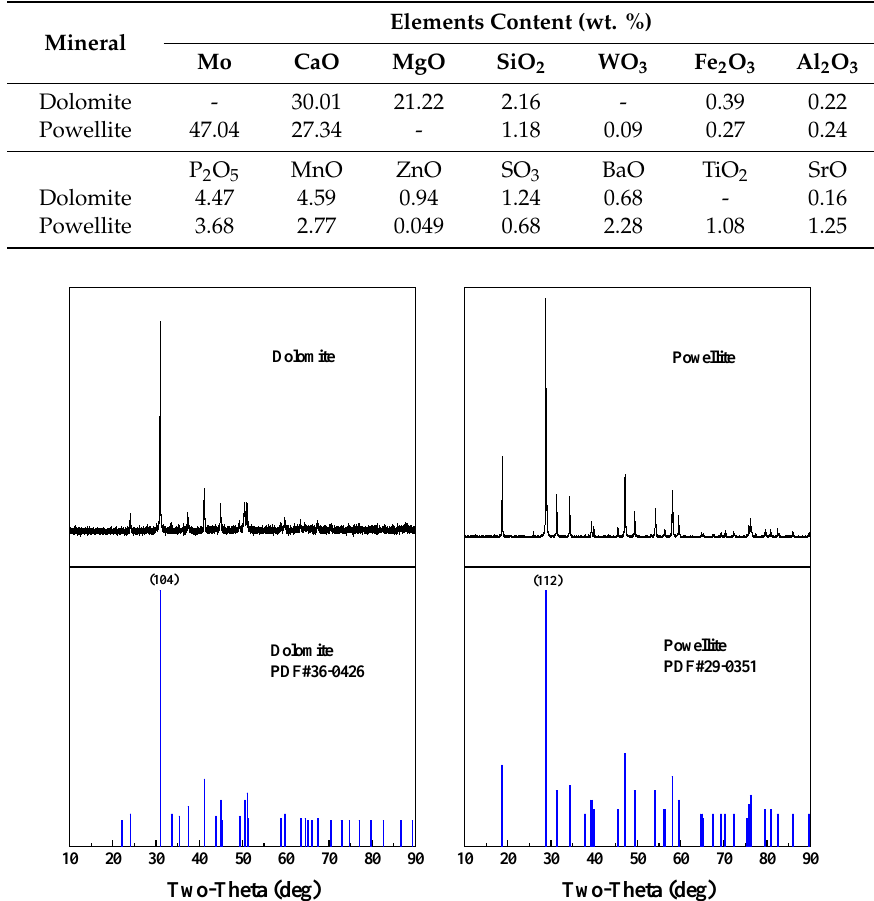
Figure 2. Experimentally obtained XRD patterns of dolomite and powellite and corresponding powder diffraction file (PDF) data.